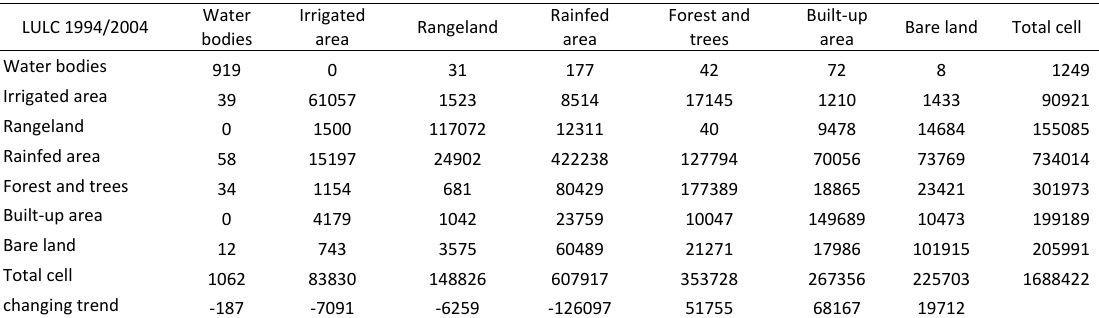
Table 6a to h ). Negative trend values were observed for the rangeland, rainfed area, bare land, forest and trees classes during the period 1984 to 2018. This means that these areas changed mainly to built-up areas, irrigated areas and water bodies. In the